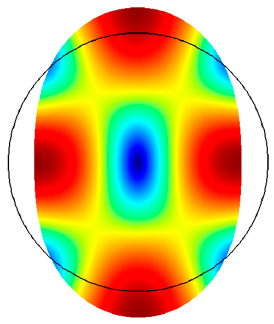
Figure 9. Wine glass mode observed in a circular disk resonator.